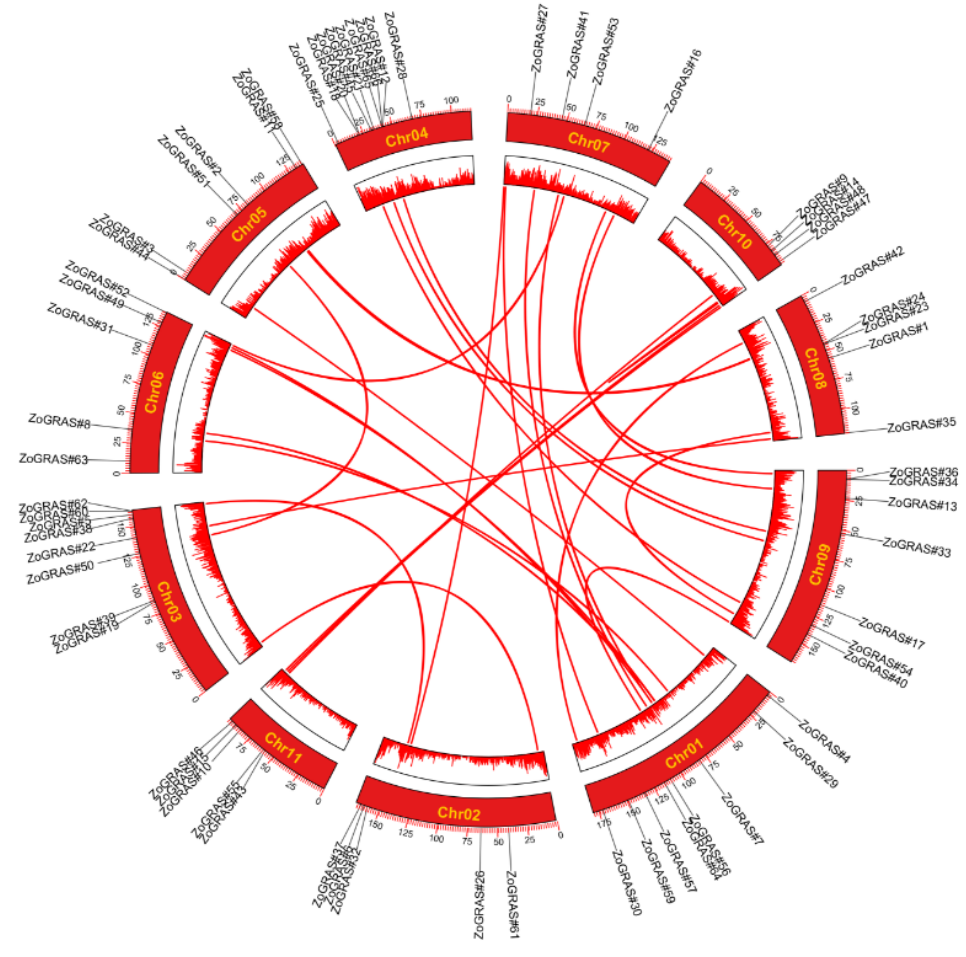
Figure 7. Diagram of chromosomal relationship of GRAS genes in ginger. The red lines represent duplicated GRAS gene pairs in ginger. The chromosome names of ginger are shown in the middle of each chromosome.